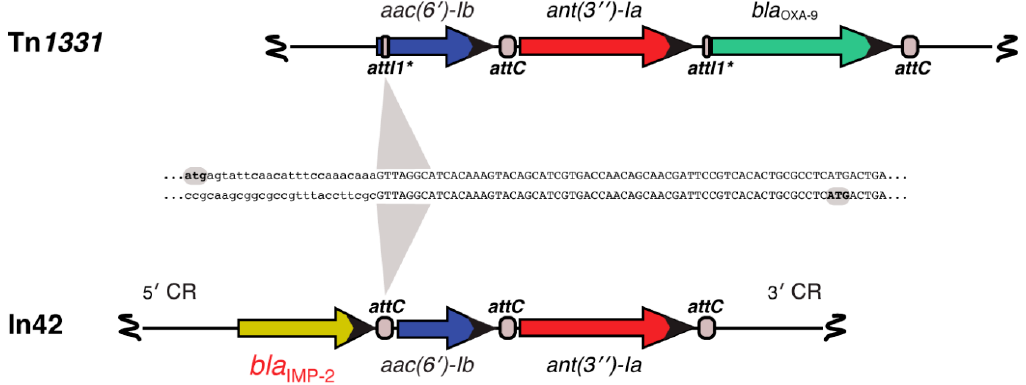
Figure 4. Comparison of the In42 variable region and a Tn 1331 resistance genes fragment. The genetic maps of the variable region of In42 and a resistance genes fragment of Tn 1331 are aligned. All attC loci are shown equally in the figure, but they are not identical at the nucleotide sequence level. The attI1* structure and functionality have been described [306]. The aac(6 ′ )-Ib genes code for proteins that show differences at the N-termini, a known characteristic of this gene [141,309,310].